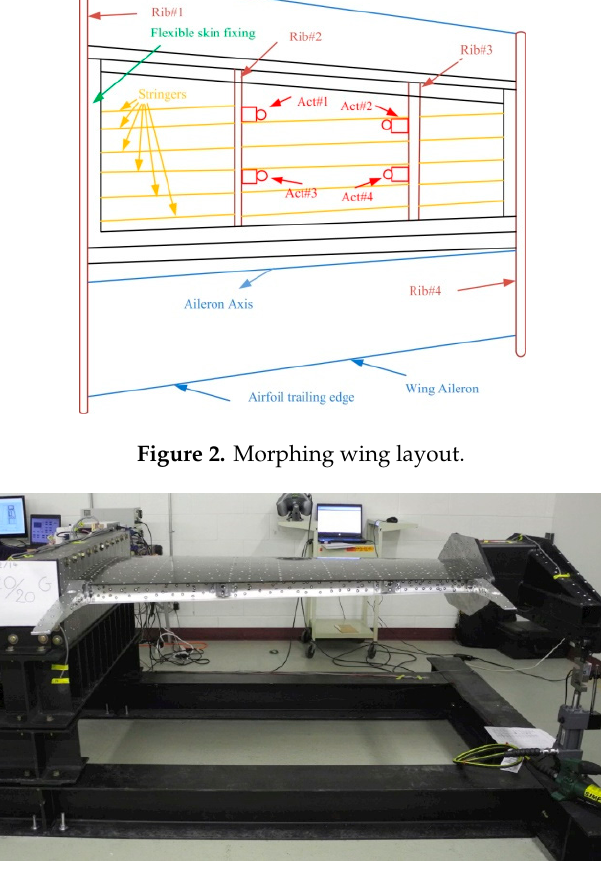
and manufactured by the Italian team [29,30].